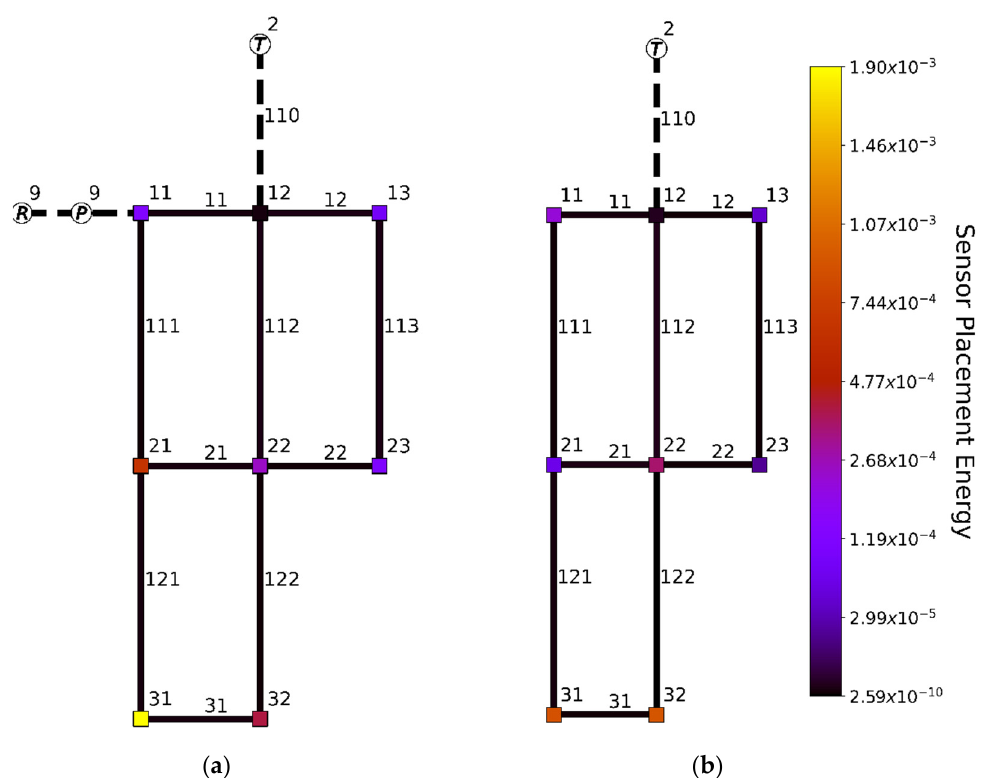
Figure 3. Optimal sensor placement for Net1 network with one tank ( T ), Reservoir ( R ), and pump ( P ) at 08:00 ( a ) and 20:00 ( b ). Black dashed lines indicate a conduit with a flow sensor. Each additional possible sensor junction and conduit is colored based on the square root of the energy corresponding with sensor placement in that specific state. At 20:00, conduit 9 is closed, thus decoupling reservoir 9 from the network.